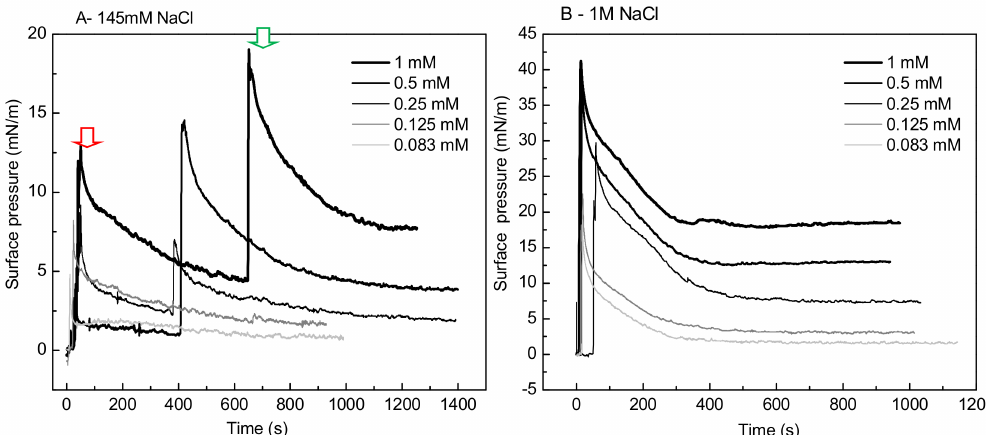
Figure 7. Effect of salt concentration on the absorption of IBU-Na. Surface pressure (at the air-buffer interface) versus time curves of increasing concentrations of IBU-Na with 145 mM ( A ) and 1 M NaCl ( B